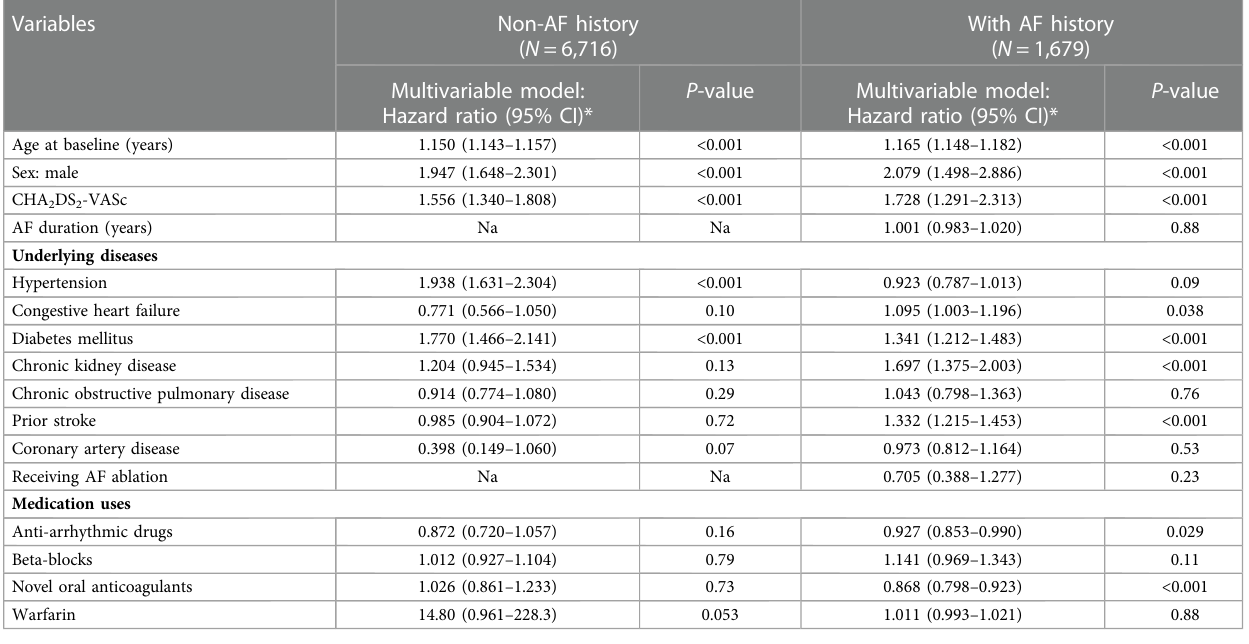
TABLE 3 Using Cox proportional hazard model to evaluate the risk of all-cause deaths in dementia patients with atrial fi brillation. Variables